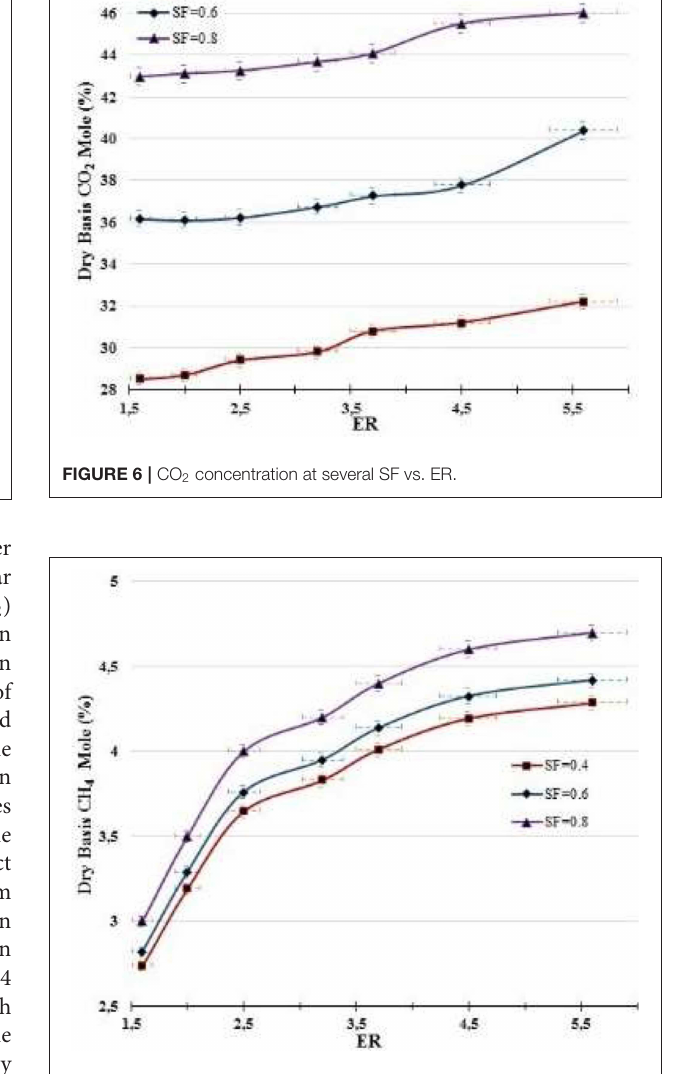
FIGURE 7 | CH 4 concentration at several SF vs.